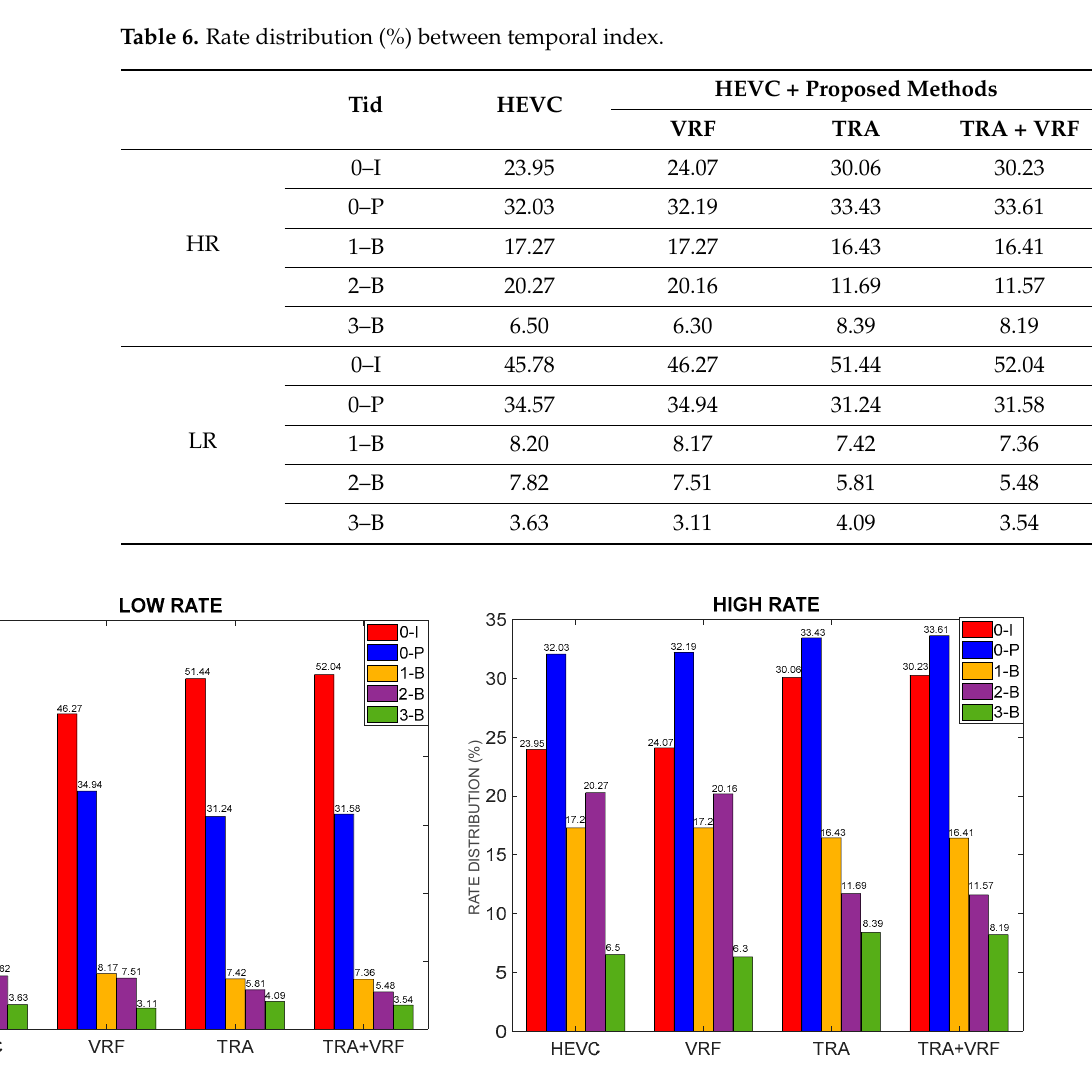
Figure 10. Rate allocation among coded pictures in GOP and for several codecs.